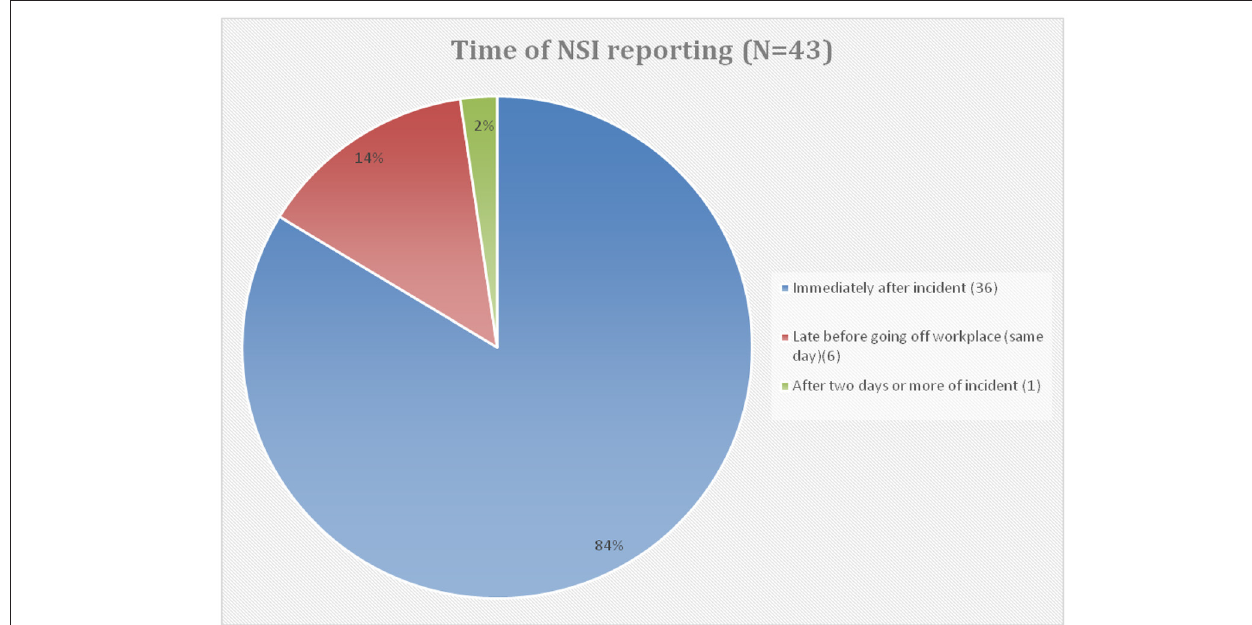
FIGURE 1 | Time of NSI reporting.